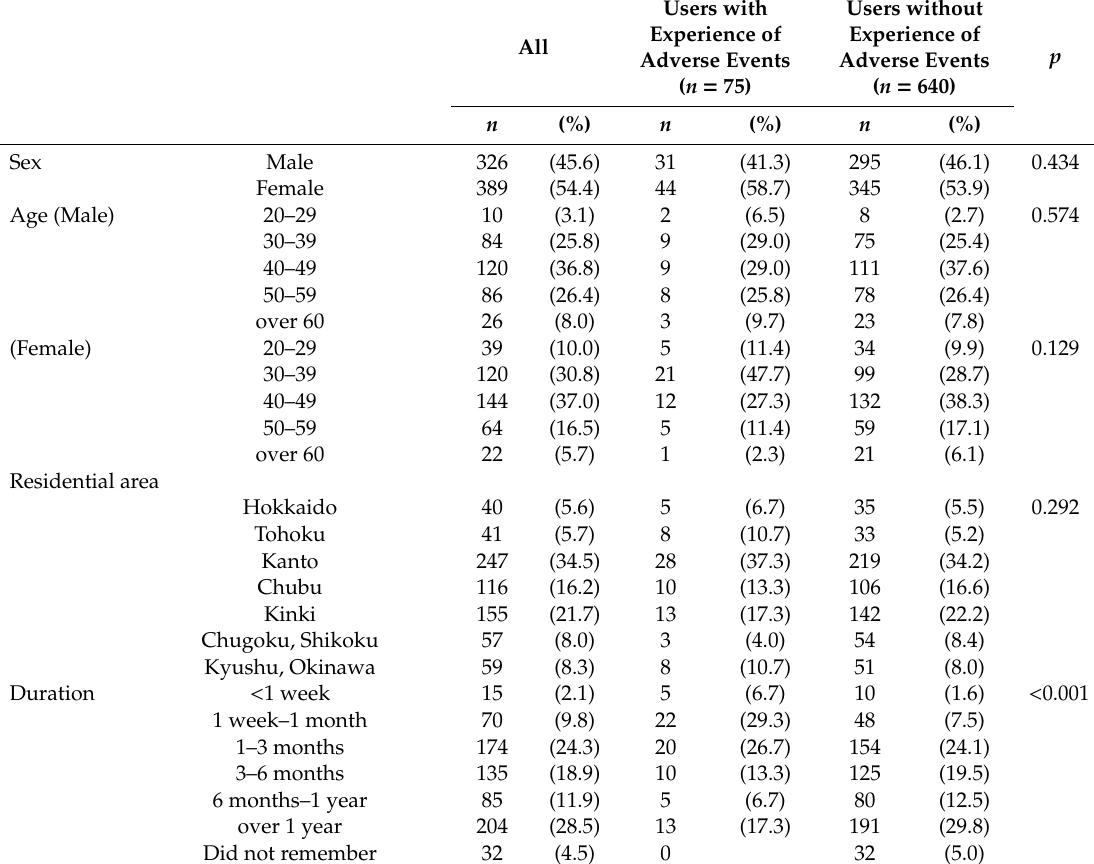
Table 1. Characteristics and use of Coleus forskohlii supplements according to those with / without experience of adverse events